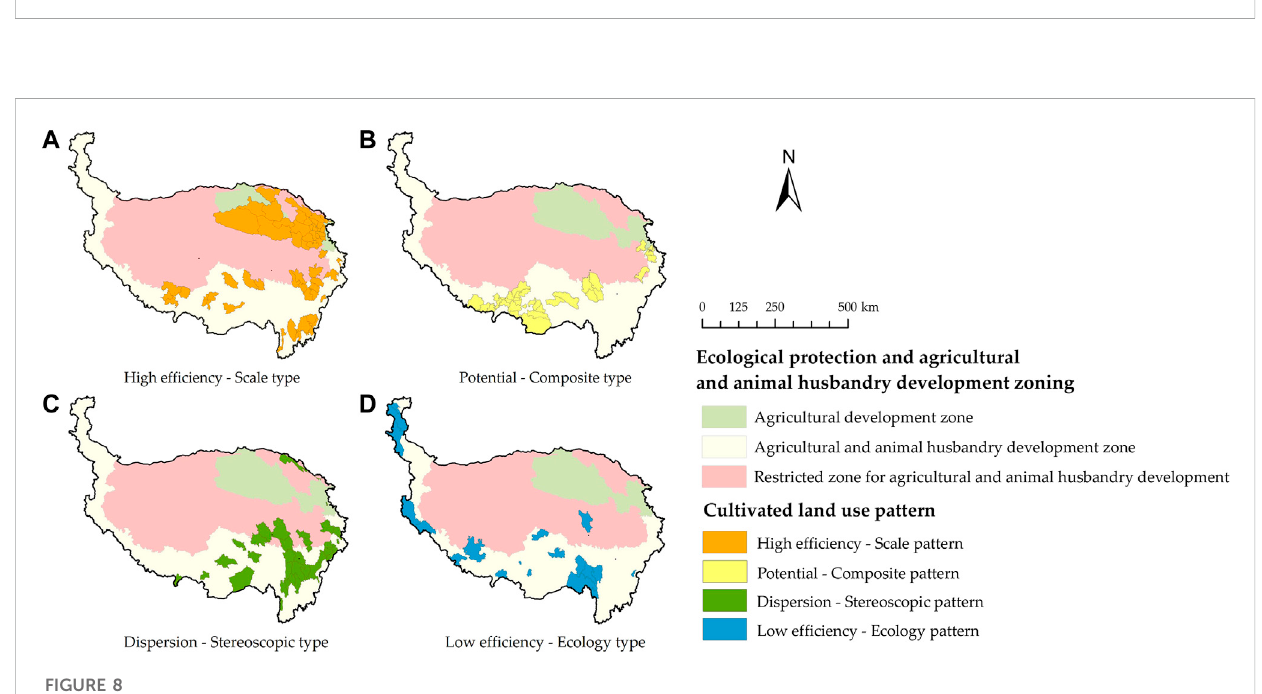
Frontiers in Environmental